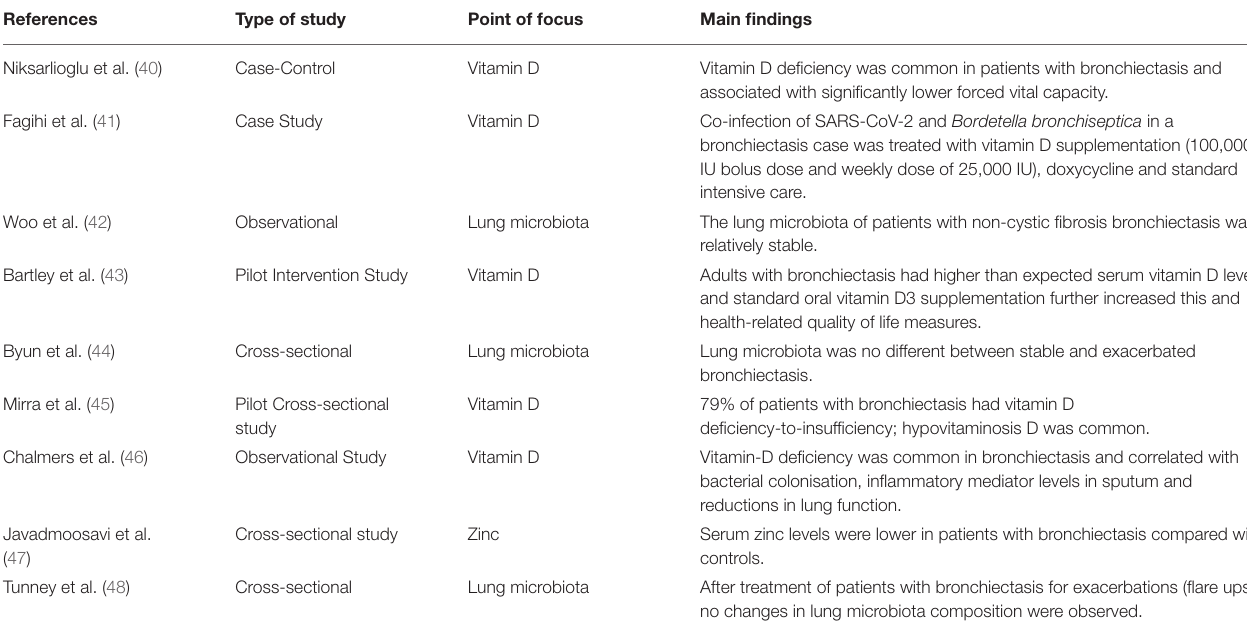
TABLE 2 | Summary of studies of nutrients and the lung microbiota in